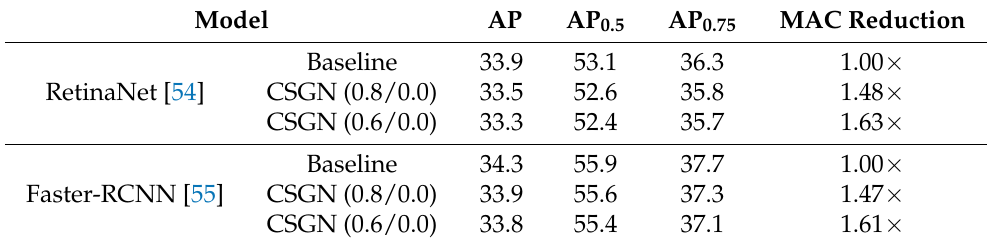
Table 5. Object detection results (bounding box AP) and the MAC reduction of the CSGN on COCO